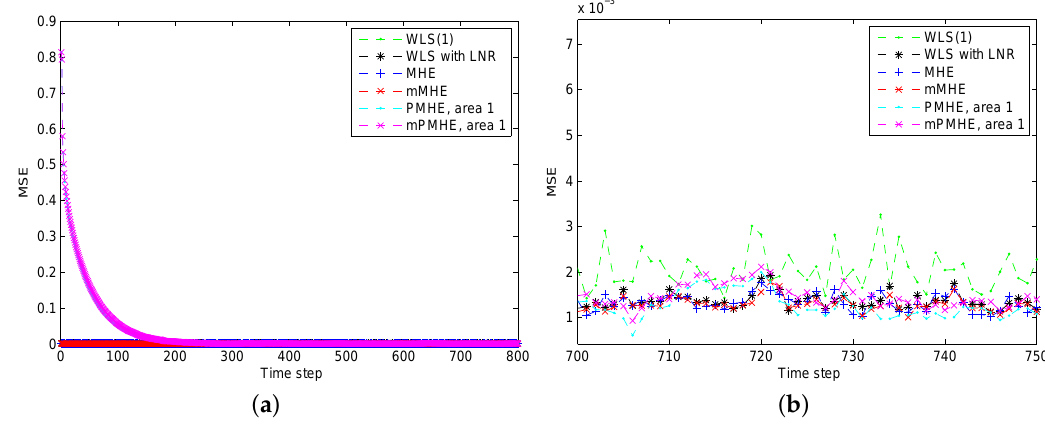
Figure 12. The Mean Square Error (MSE) of WLS(1) (the horizon length of measurements is 1), RLS, MHE, mMHE, PMHE and mPMHE with constraints in the IEEE 118-bus system with redundant observations. ( a ) The MSE from step 1 to 800. ( b ) The details of MSE from step 700 to